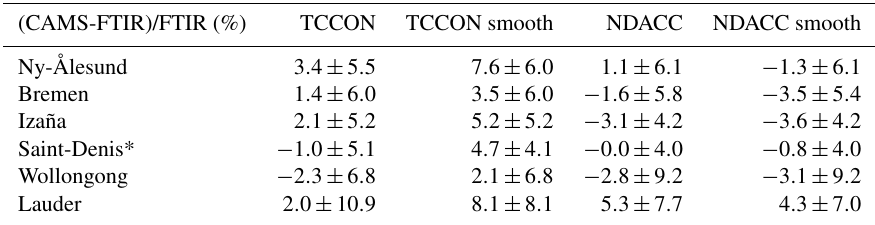
Figure 8. The scatter plots between the TCCON X CO retrievals and the smoothed AirCore X CO measurements at Orléans (a) and So- dankylä (b) . The black line is the one-to-one line, and the red dashed line is the linear fitting (forced to cross the zero). The data are colored their measurement times in each month. The error bar of the TCCON X CO retrieval is the daily SD, representing the random uncertainty of the TCCON data, while the error bar of the AirCore data is the total uncertainty for each measurement. N is the number of co-located measurements, R is the correlation coefficient and a is the slope of the fitting line. Table 6. The mean and SD of the relative difference between the CAMS and FTIR (TCCON and NDACC) X CO data, with and without smoothing. Saint-Denis *: TCCON data are from the Saint-Denis site, while NDACC data are from the Maïdo